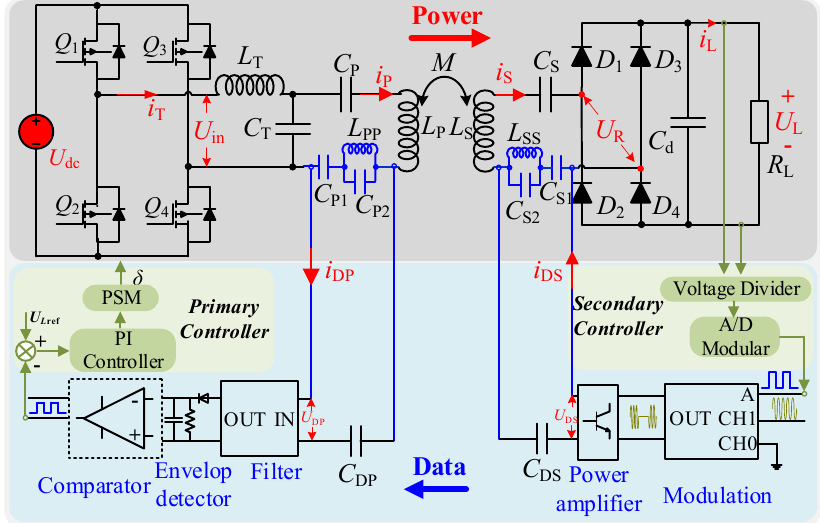
Figure 1. The proposed power and data parallel transmission circuit.